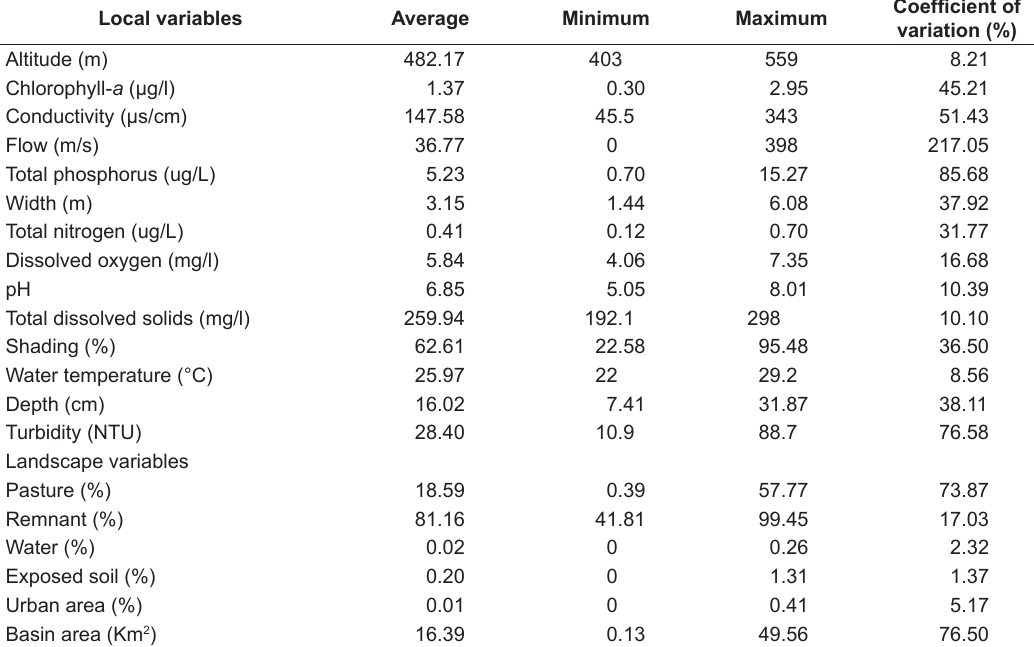
Table 2. Statistical descriptors of local and landscape variables measured in the studied streams. Local